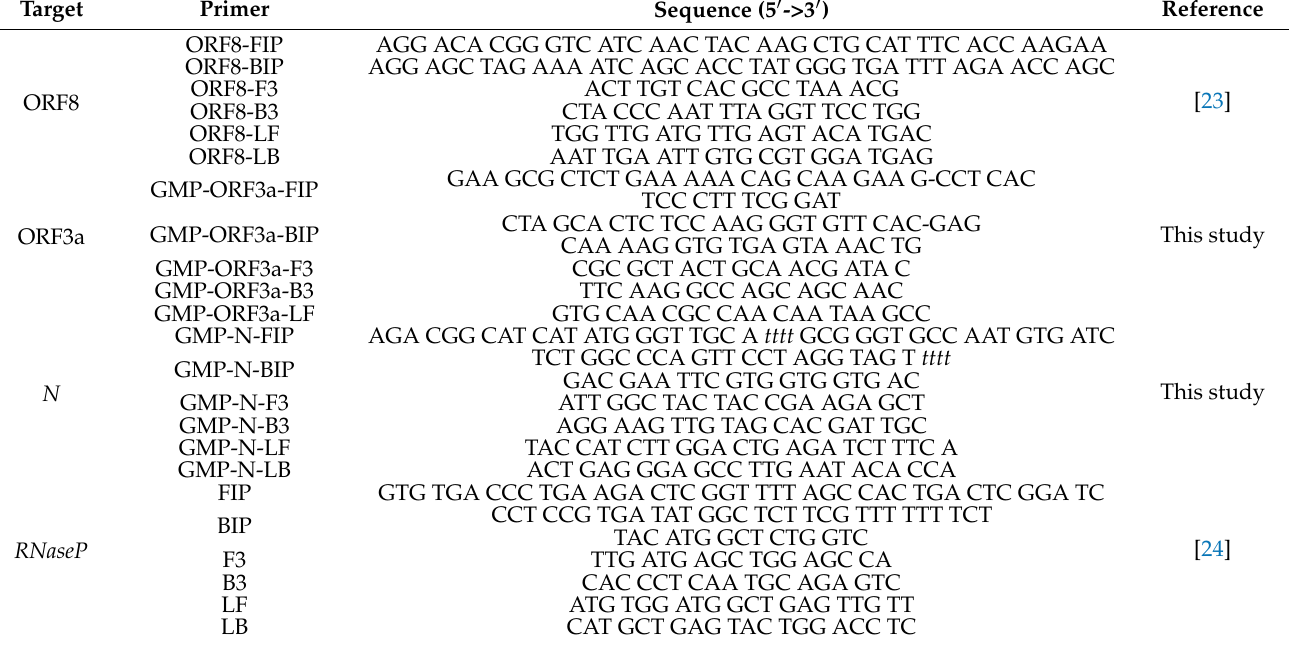
Table 1. LAMP primers.